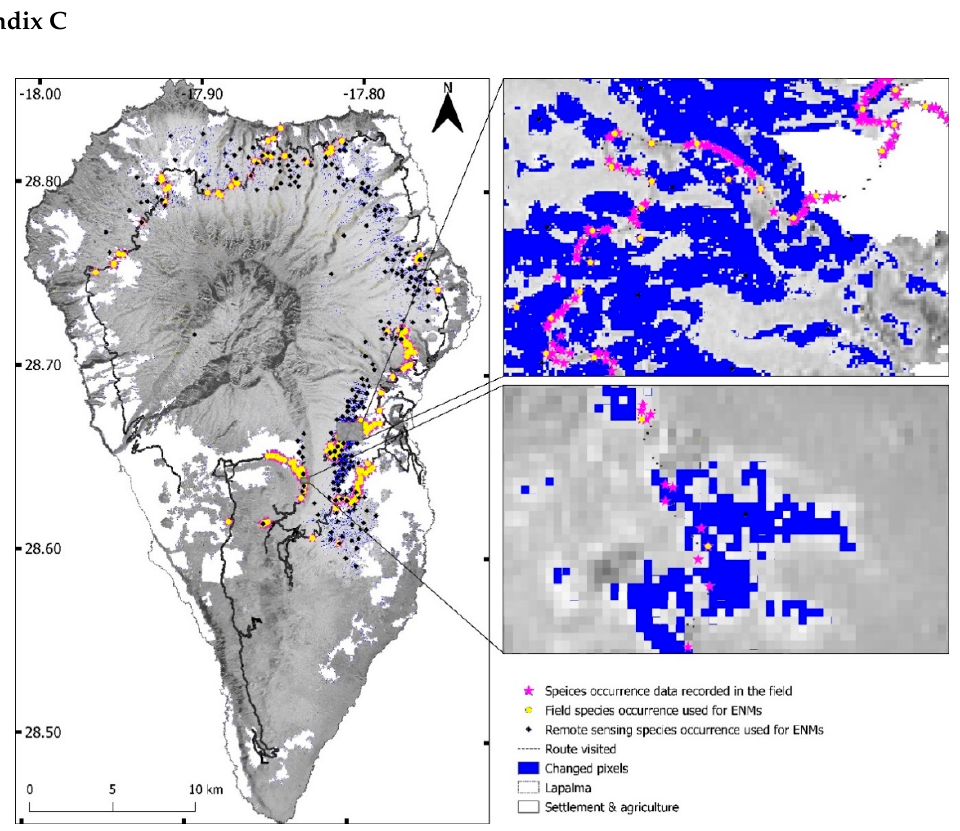
Table A2. Total number of training and testing data used in Random Forest classification.